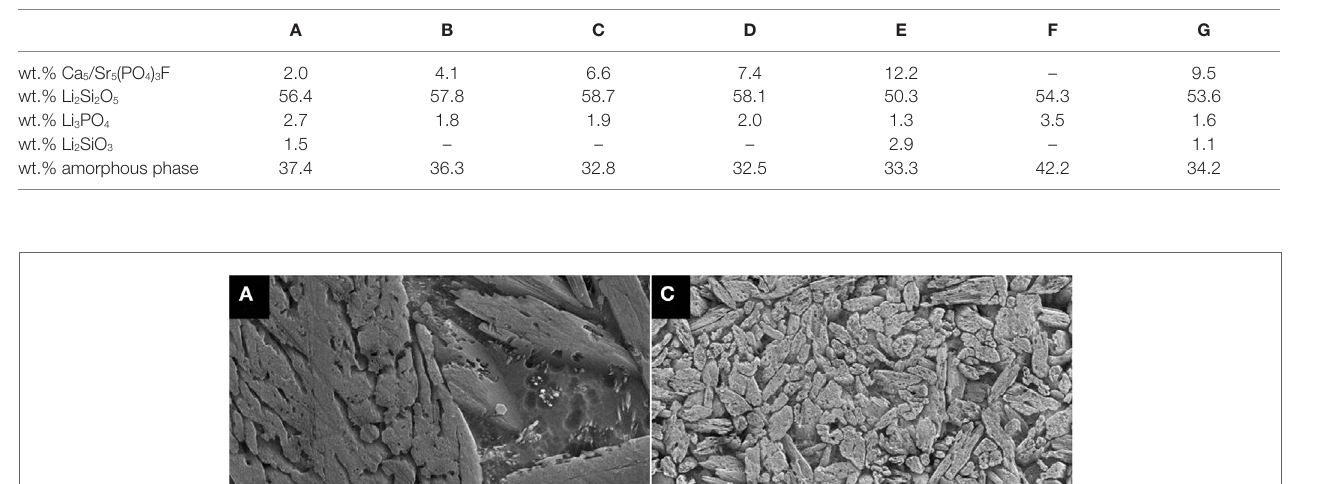
TaBle 3 | Qualitative and quantitative composition of glass–ceramics after subsequent heat treatment at 500 and 800°c for a duration of 30 min